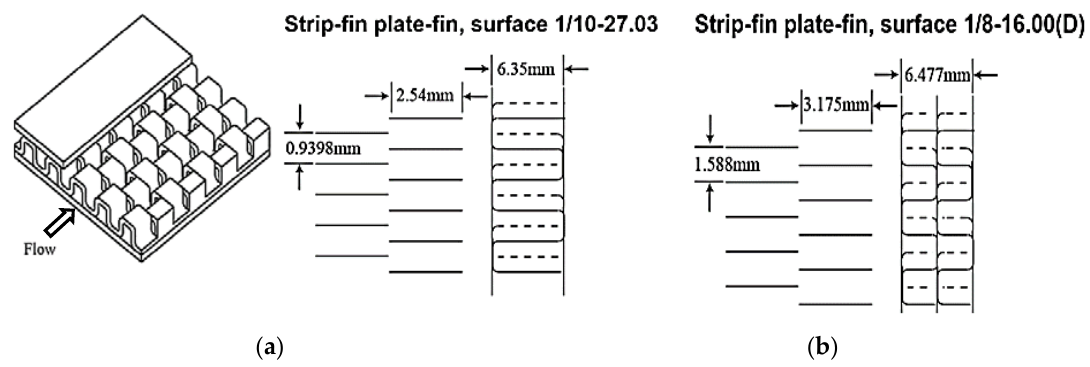
Figure 8. Fin geometries and arrangement considered for the recuperator model validation [24]. ( a )